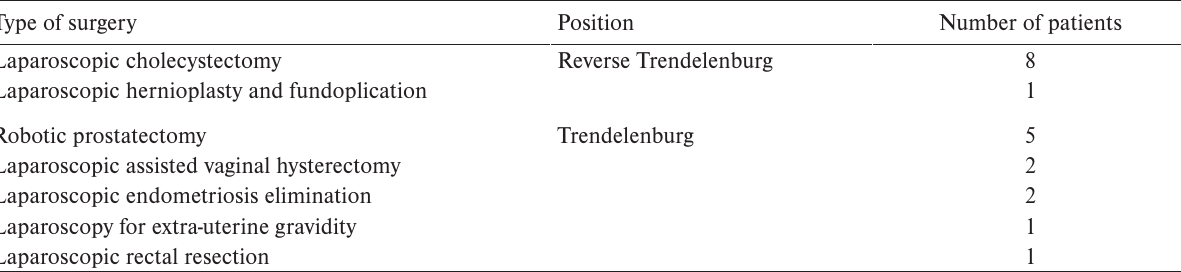
Table 1. Types, patient position and numbers of performed surgeries. Type of surgery